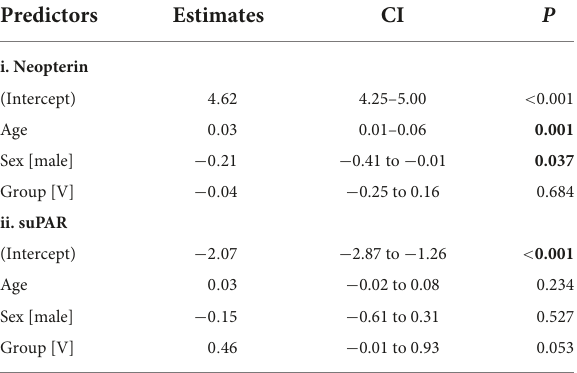
TABLE 1 Relationships between log-transformed values of urinary (i) neopterin and (ii) suPAR measured in ng/mg creatinine.